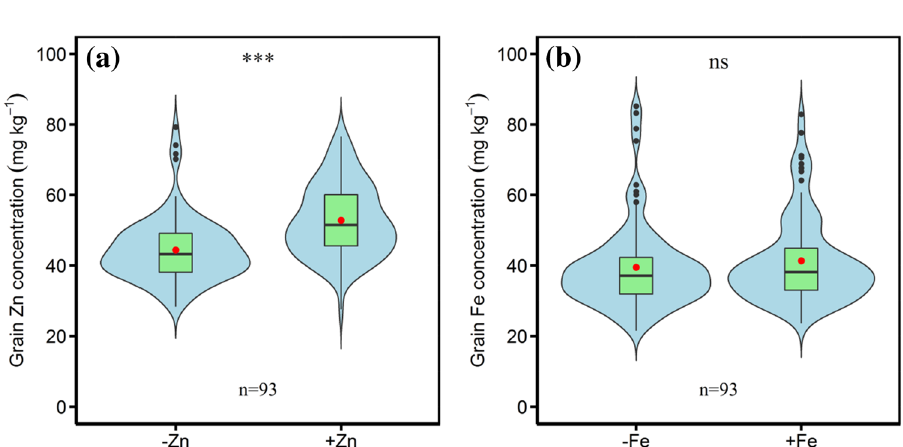
Figure 4. Effects of foliar application of micronutrients on the grain concentrations of ( a ) zinc and ( b ) iron of the ninety-three wheat accessions. Note: −Zn and + Zn indicate without and with foliar zinc application, respectively, − Fe and + Fe indicate without and with foliar iron application, respectively. The boxes boundaries indicate the 75% and 25% quartiles; whiskers indicate the 95% confidence limits; the black circles indicate outliers; the solid horizontal line and red circle indicate median and mean, respectively. * ** is statistically significant at P < 0.001, ns indicate not significant at P < 0.05.